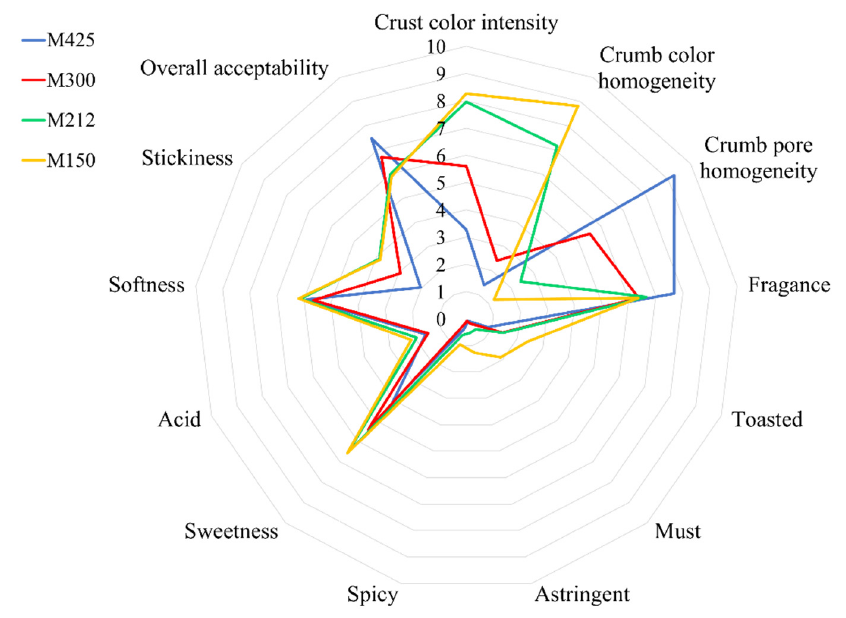
Figure 4. Results of the sensory analysis of the experimental muffins. Data are represented as means ± SD of nine replicates. M425, muffin with addition of grape pomace powder at 600–425 µ m; M300, muffin with addition of grape pomace at 425–300 µ m; M212, muffin with addition of grape pomace powder at 300–212 µ m; M150, muffin with addition of grape pomace powder at 212–150 µ m.